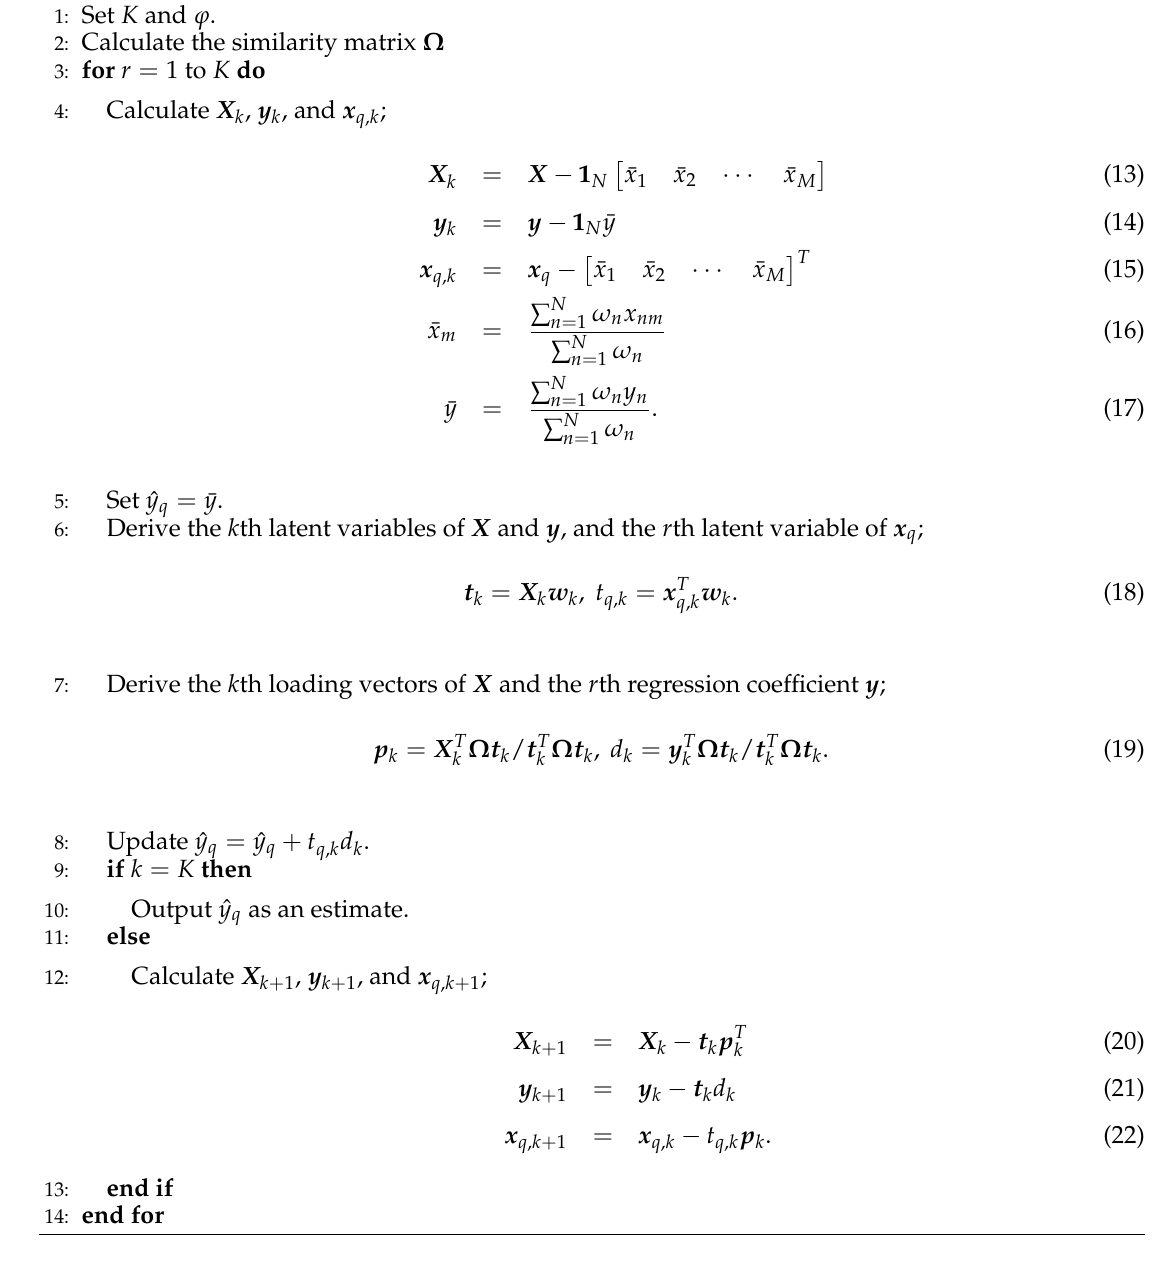
Algorithm 2 describes a procedure of LWPLS based on the NIPALS algorithm. Steps 4–7 derive the latent variable t , the loading vector p , and the regression coefficient vector b iteratively. In step 6, Ω y Ω X T w k is calculated as the eigenvector of X T k y k , which corresponds to the maximum eigenvalue. k k The final estimate is output when k = K . A localization parameter ϕ and the number of latent variables K are tuning parameters, which are determined by trial and error or cross-validation. Algorithm 2